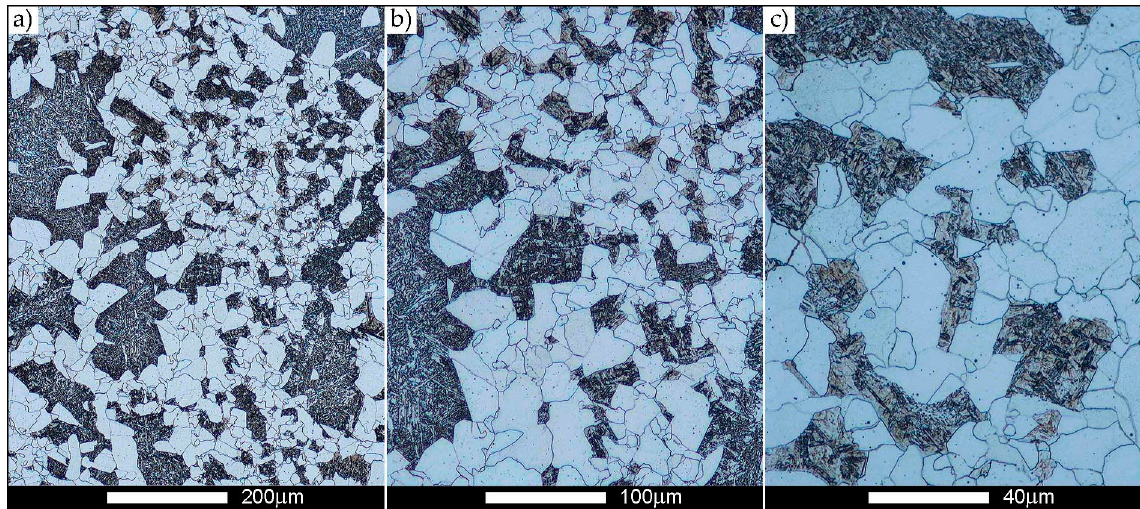
Figure 47. Welded joint microstructure of Hardox 450 steel with visible prior austenite grain boundaries, austenitised at 1100 °C—WM3 zone shown in Figure. 2. ( a ) 100×; ( b ) 200×; ( c ) 500×.